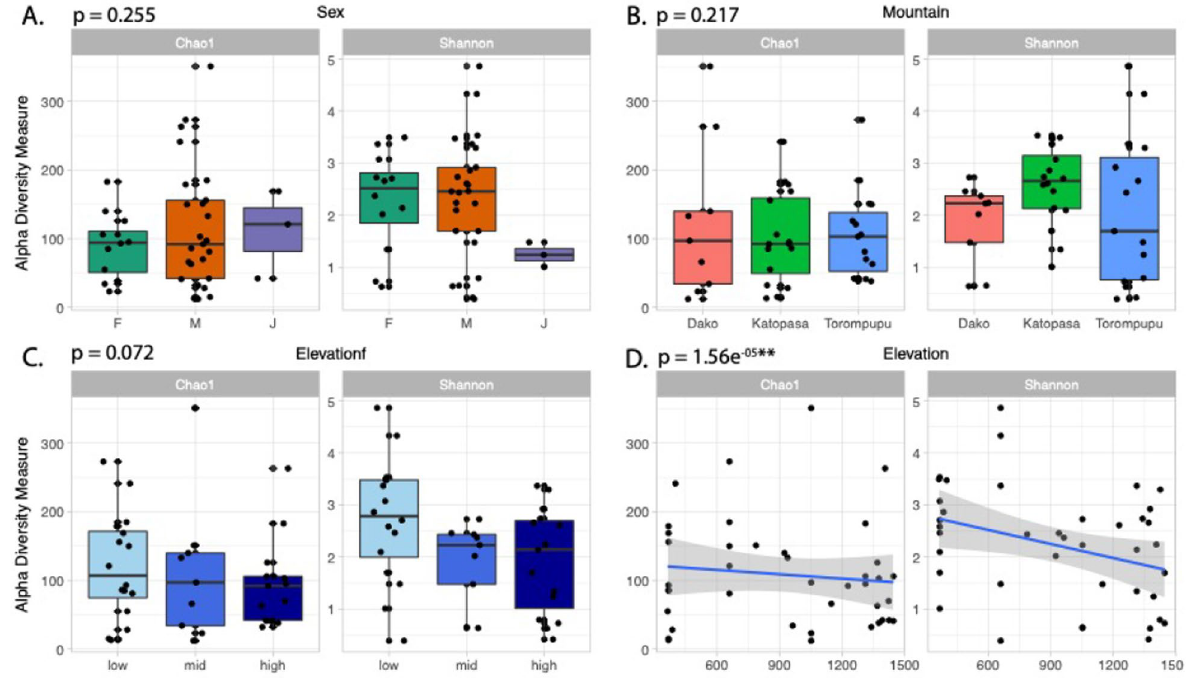
Fig. 3 Microbial alpha diversity plots and associated p values using number of ASVs and Shannon Index compared by the variables: A sex (adults) and juveniles, B mountain, C elevational as a factor (low